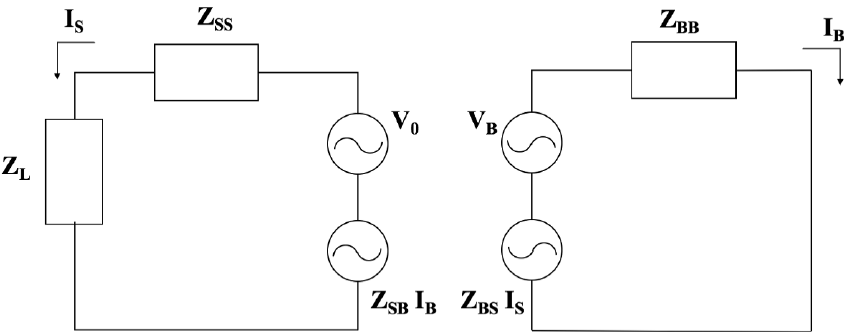
Figure 2. The equivalent circuit used for the electrical representation of the body–sensor coupling where Z SB = Z BS is the mutual-coupling between the sensor and the human body; Z SS and Z BB are the impedances of the sensor and of the human body respectively.